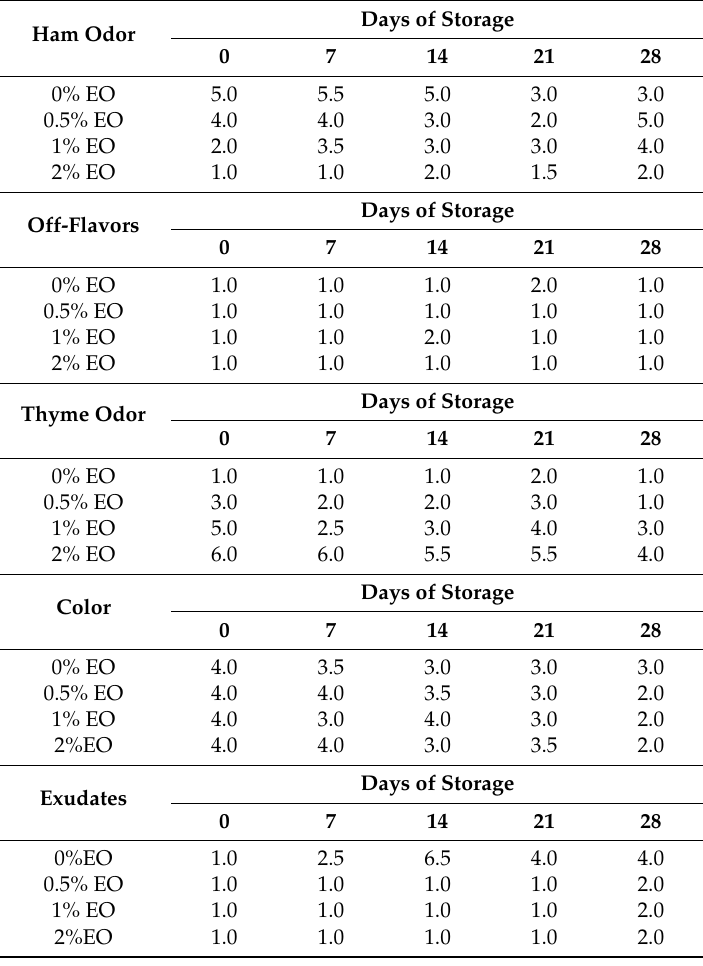
Table 5. Sensory descriptors (median) of RTE meat packaged during refrigerated storage (0%